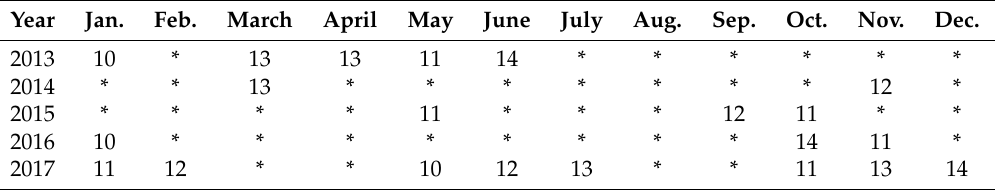
Table 11. Number of suicides a month among youths under 23 in the period 2013–2017.